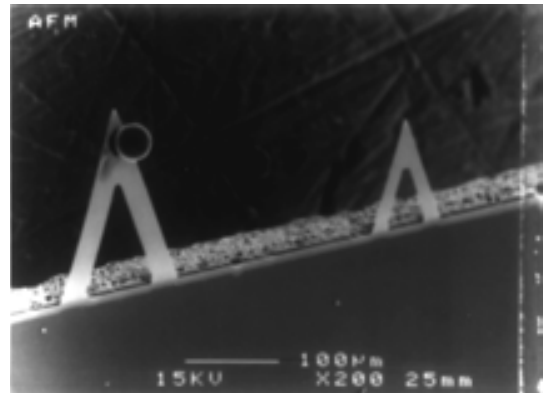
Figure 5. SEM micrograph of a glass sphere attached to an AFM